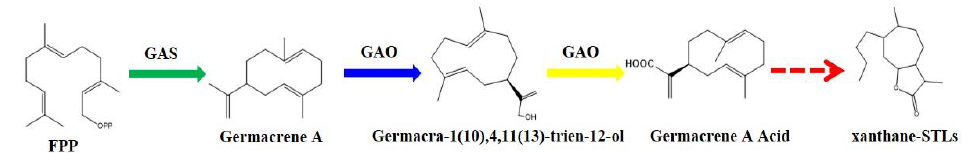
Figure 2. Hypothesized STL biosynthetic pathway in X. sibiricum.